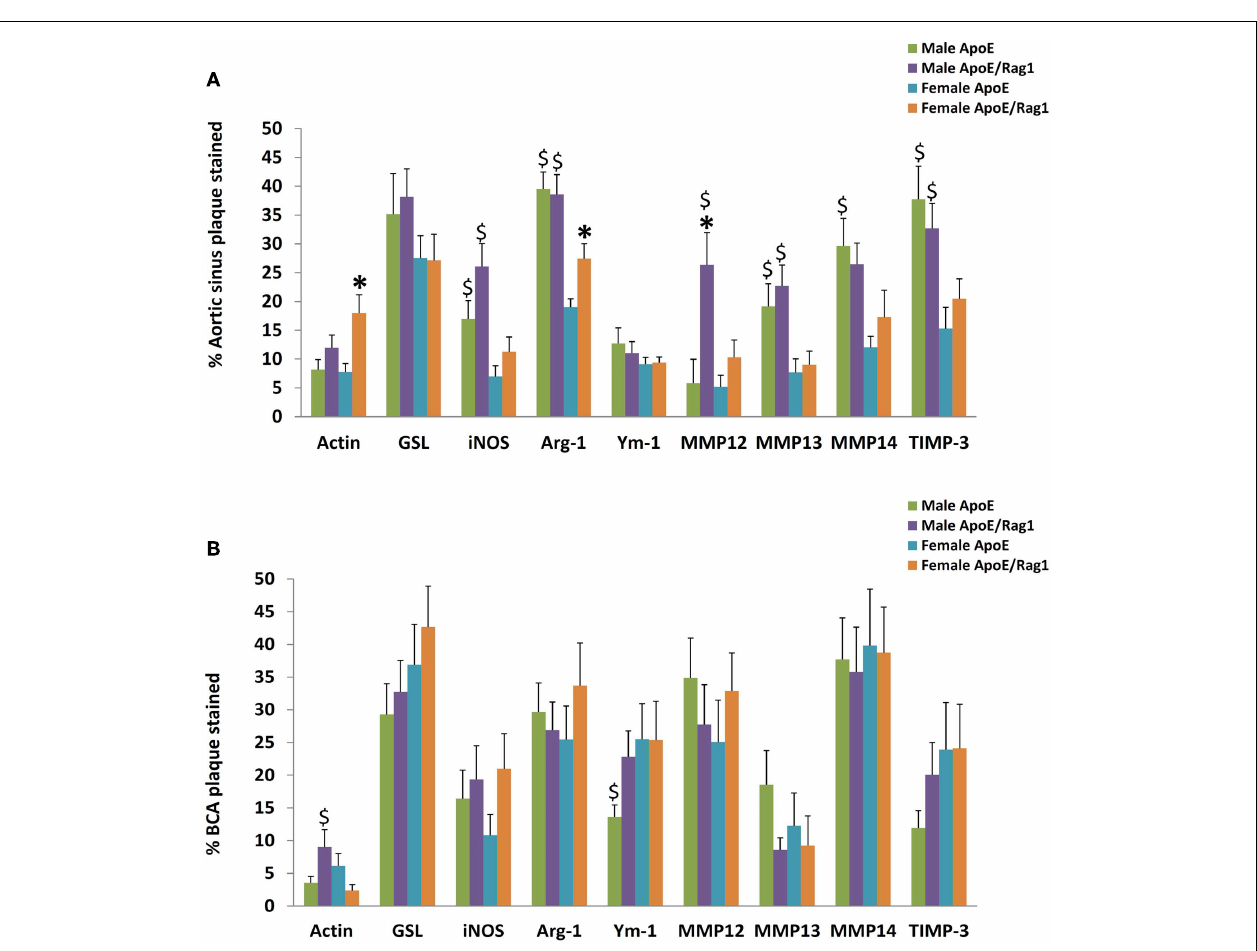
FIGURE 8 |The proportion of staining for cell type, M1/M2 markers, MMPs, andTIMPs in plaques fromApoE KO orApoE/Rag1 DKO mice . (A) Aortic sinus plaques. (B) Brachiocephalic artery plaques.Values are expressed as mean and SEM. * P < 0.05 vs. DKO, $ P < 0.05 indicates gender differences for that genotype, n =